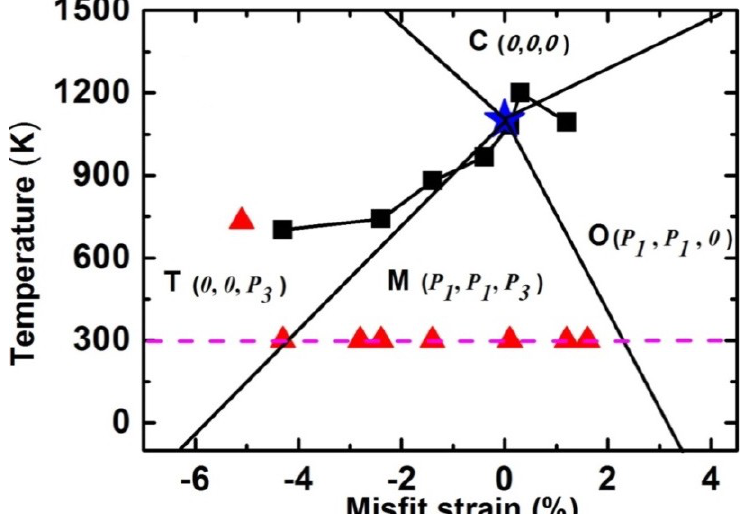
Figure 1. Misfit strain and temperature-dependent phase transition of strained BiFeO (BFO) films (Data adapted from [22,29,30,35,48,49], Star symbol denotes T Triangle symbols denote strain induced phases at room temperature; Square symbols denote T of strained BFO c